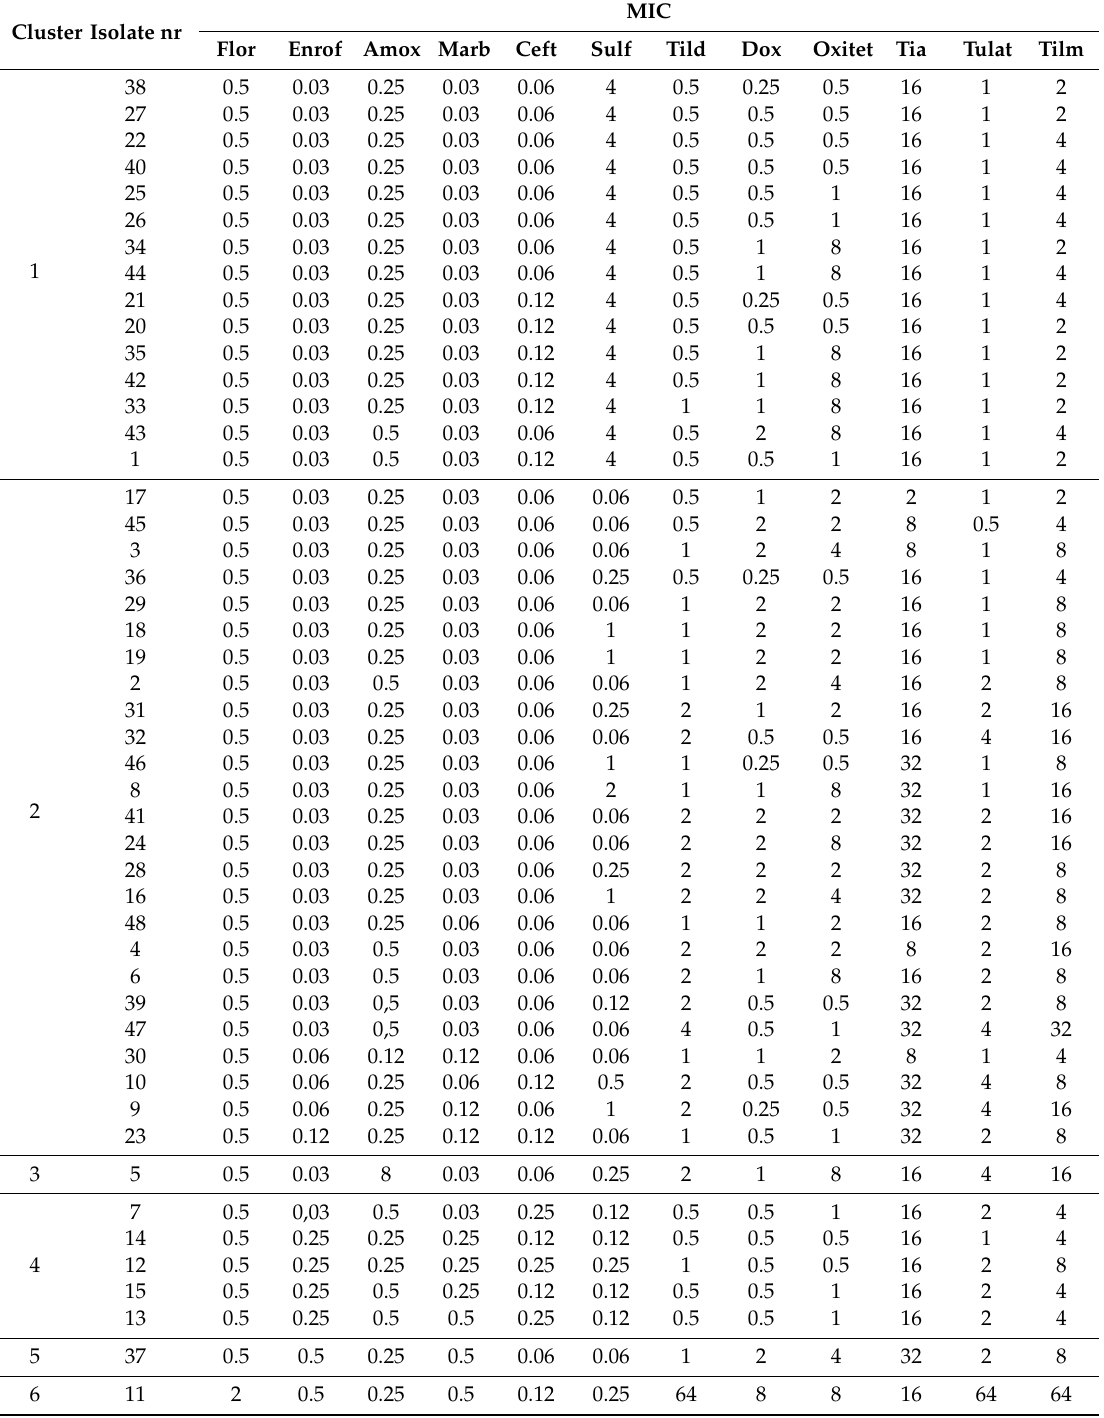
Table 5. MIC values of the 48 Pasteurella multocida isolates grouped into six clusters after a hierarchical clustering analysis for the 12 antimicrobials